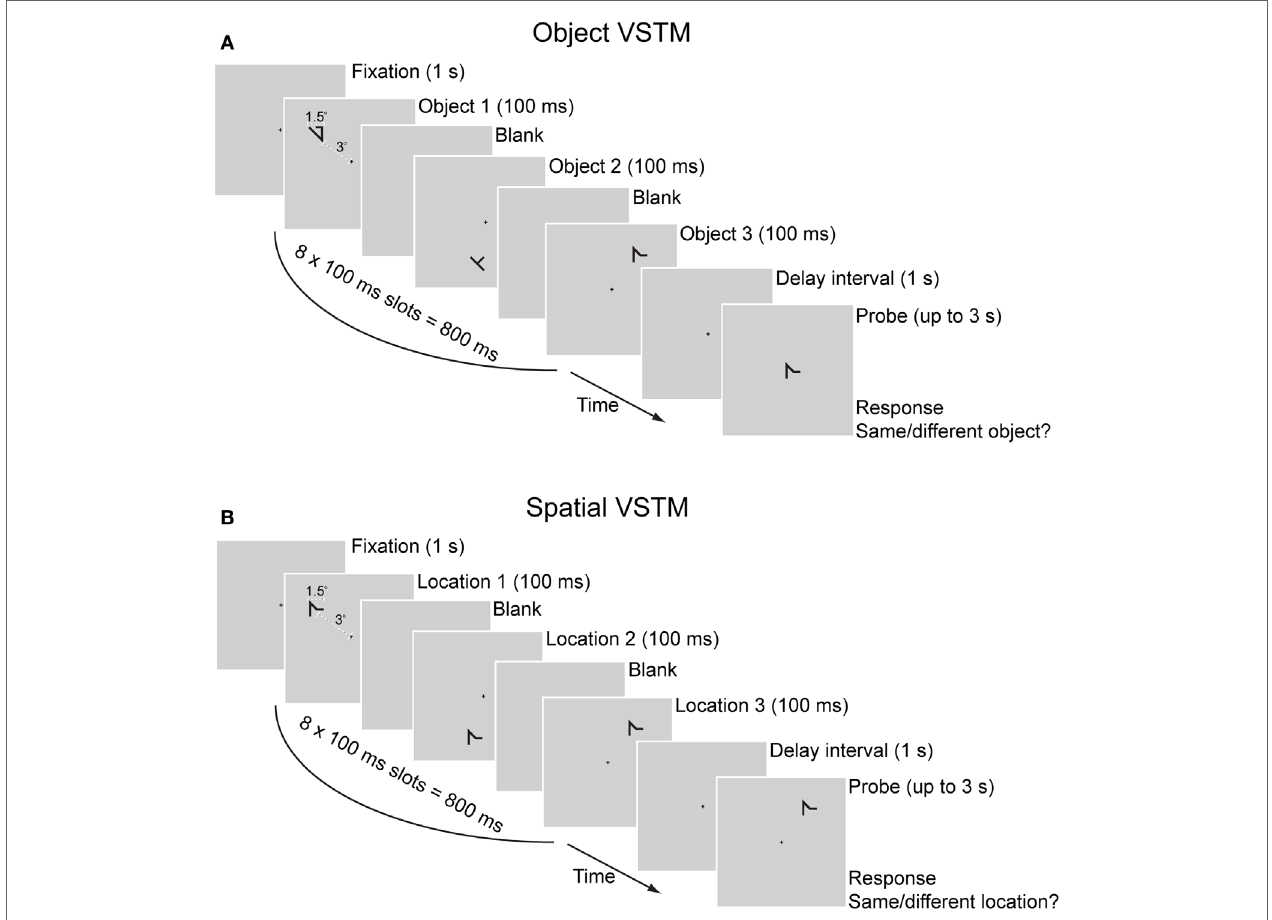
FigUre 2 | Visual short-term memory task . Each trial had a duration of up to 5.8 s. Trials started with fixation cross for 1 s, followed by eight sample displays with a duration of 100 ms each (total sample displays duration was 800 ms), a blank delay interval (1 s), and a test display/response period (up to 3 s). An auditory tone (“beep”) was used as feedback for incorrect responses. Each item in the memory-set appeared in one of the eight sample displays in random order (e.g., in a trial with a set size of three items shown here, each of the three items was randomly assigned to one of the eight sample displays). Participants were instructed to maintain the memory-set items in VSTM throughout the retention interval by visually projecting them on the screen while avoid verbalizing them. During the response period, participants pressed a button to respond whether the memory probe item was of the same identity as any of the memory-set items (a) or it appeared at the same location as any of the memory-set items (B) . In order to minimize load on object VSTM, all items in the spatial memory-set task were of the same identity. Responses were made on a standard QWERTY keyboard with the right index and middle fingers pressing the numeric keypad buttons 1 for “same” and 2 for “different”, respectively. The memory probe was a match on half of the trials, and appeared at a different location (for the spatial VSTM task) or was of a different shape (for the object VSTM task) on the other